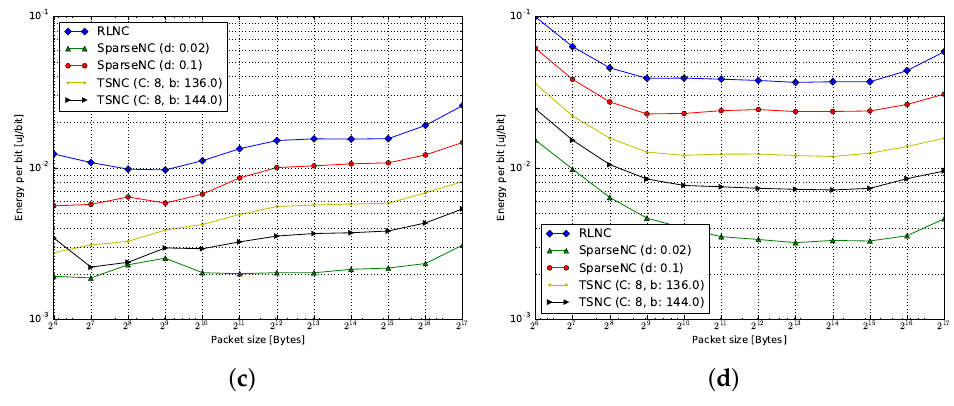
Figure 11. Encoder energy measurements for the Raspi 1. ( a ) Energy per bit vs. generation size for q = 2; ( b ) energy per bit vs. generation size for q = 2 8 ; ( c ) energy per bit vs. packet size for q = 2, g = 128; ( d ) energy per bit vs. packet size for q = 2 8 , g = 128.